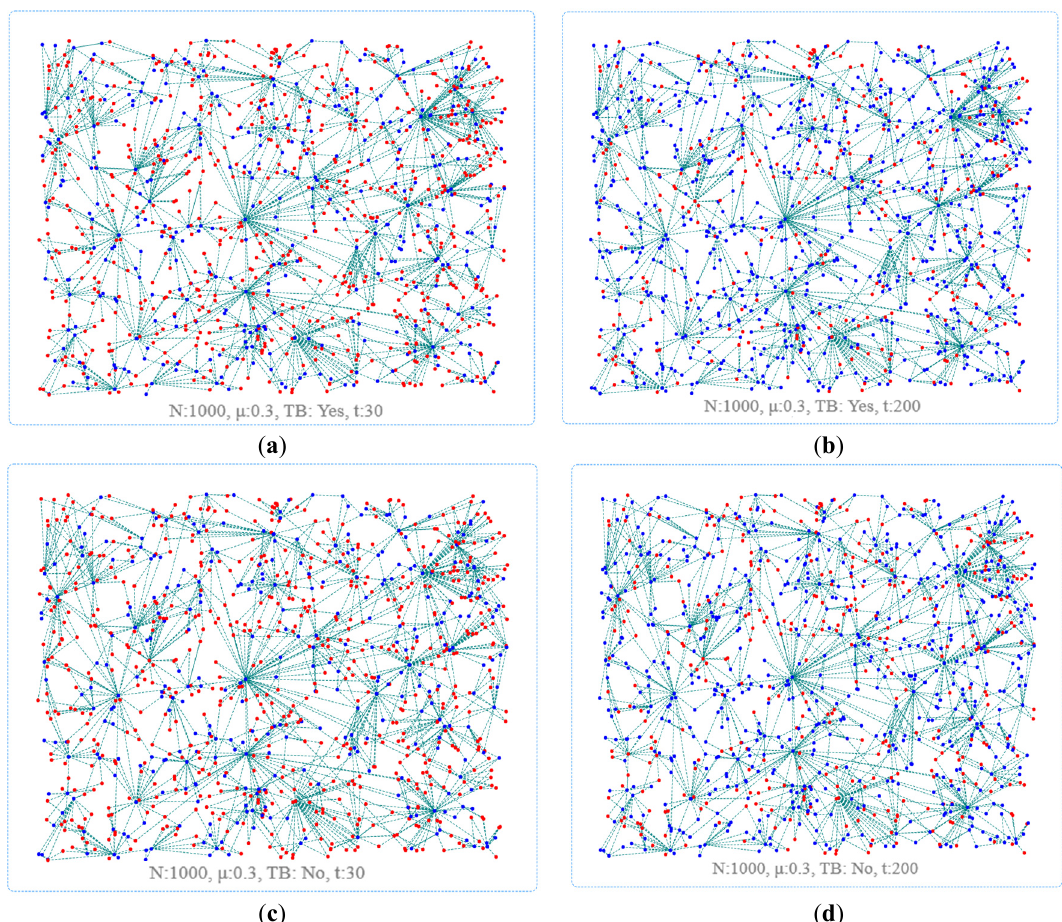
Figure 6. Influence of CID on BCW under trust boundary (number of firms = 1000). Note: the red node means normal bidders, the blue means collusive bidders, and the node’s size represents the degree of the node.